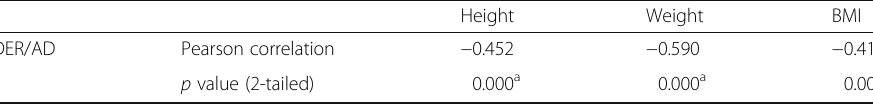
Table 3 DER/AD and height, weight, and BMI Height Weight BMI DER/AD Pearson correlation − 0.452 −